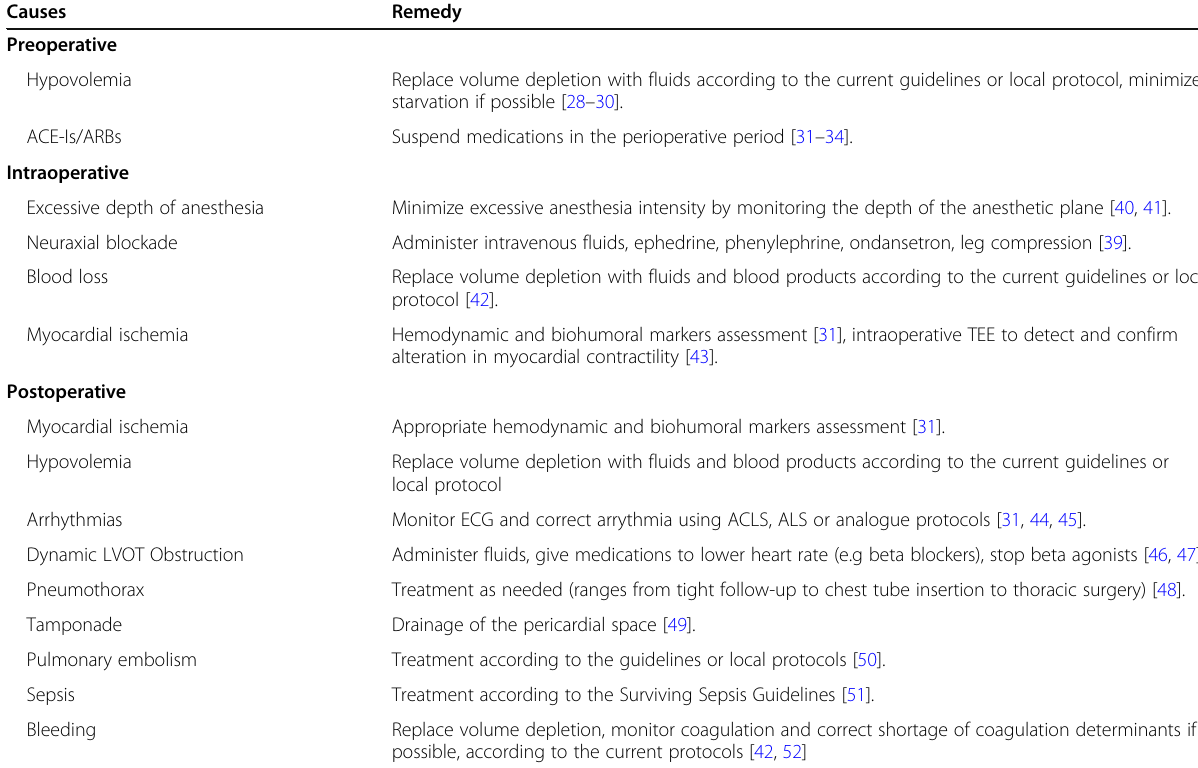
Table 1 Specific causes and remedies for perioperative hypotension Causes